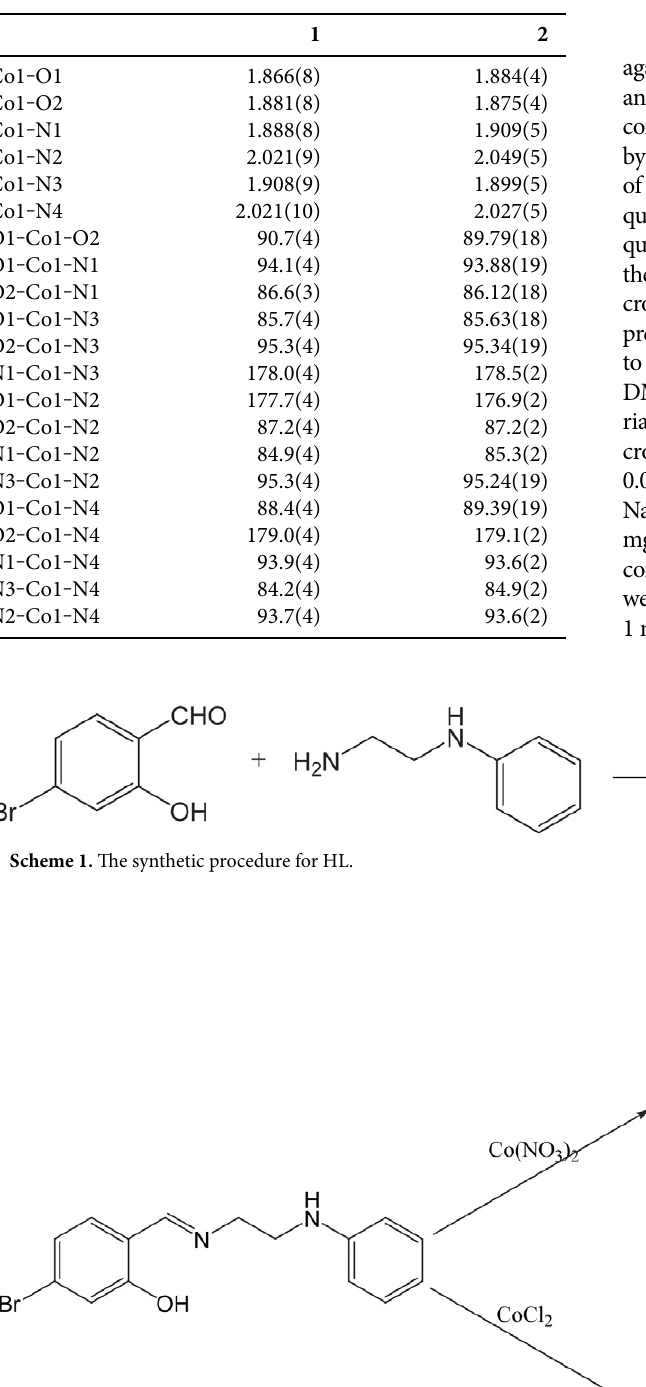
Table 2. Selected bond distances (Å) and angles (º) for the